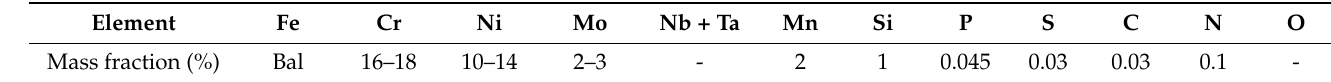
Figure 2. ( a ) SEM micrograph of powder; ( b ) particle size distribution of commercial SLM solutions 316L powder. Table 1. The chemical composition of 316L steel powder obtained from SLM solutions.